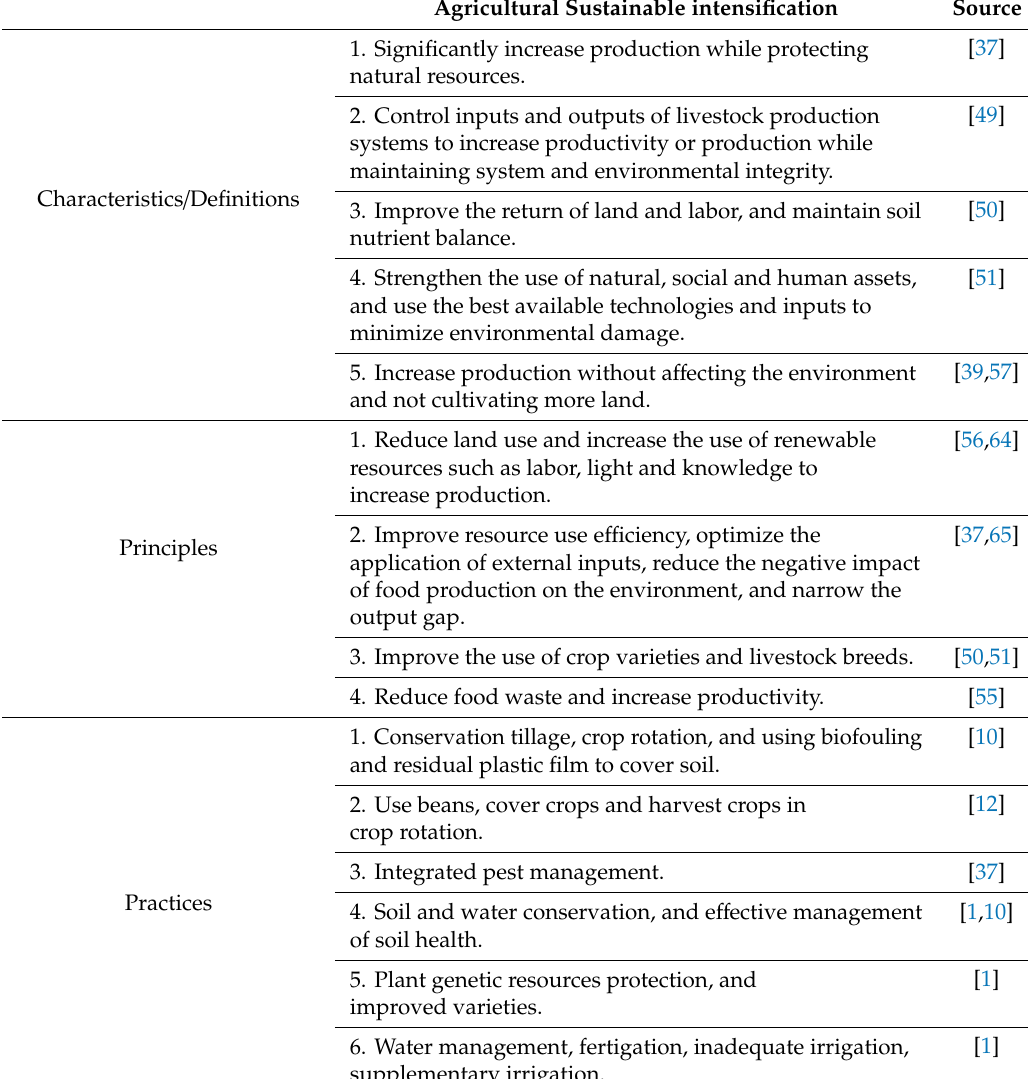
Table 1. Characteristics / definitions, principles and practices of agricultural sustainable